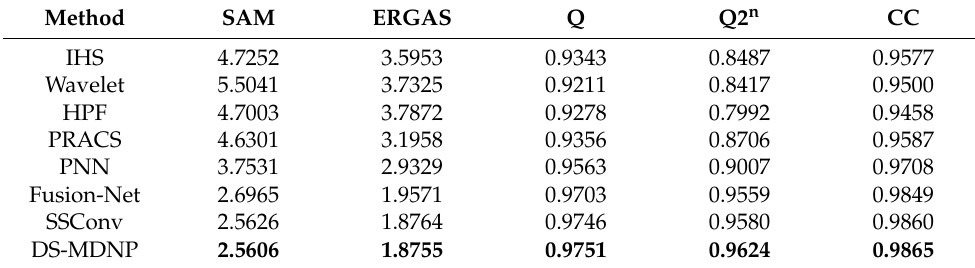
Table 6. Quantitative evaluation comparison of fusion results on the WorldView-2 dataset. The values in bold represent the best